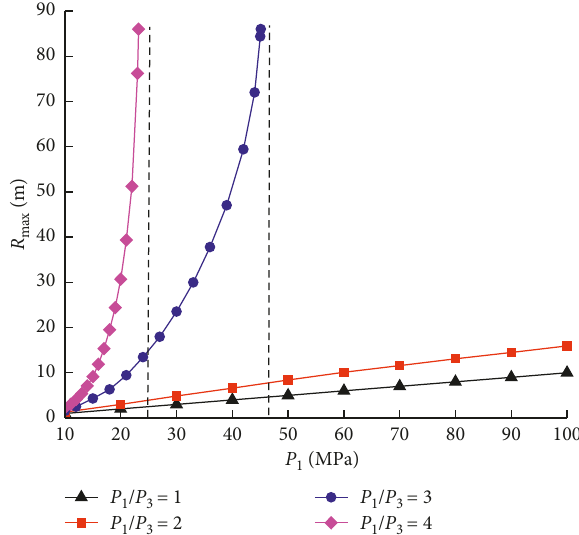
Figure 7: Relationship between maximum radius of plastic zone and maximum confining pressure under different confining pressure